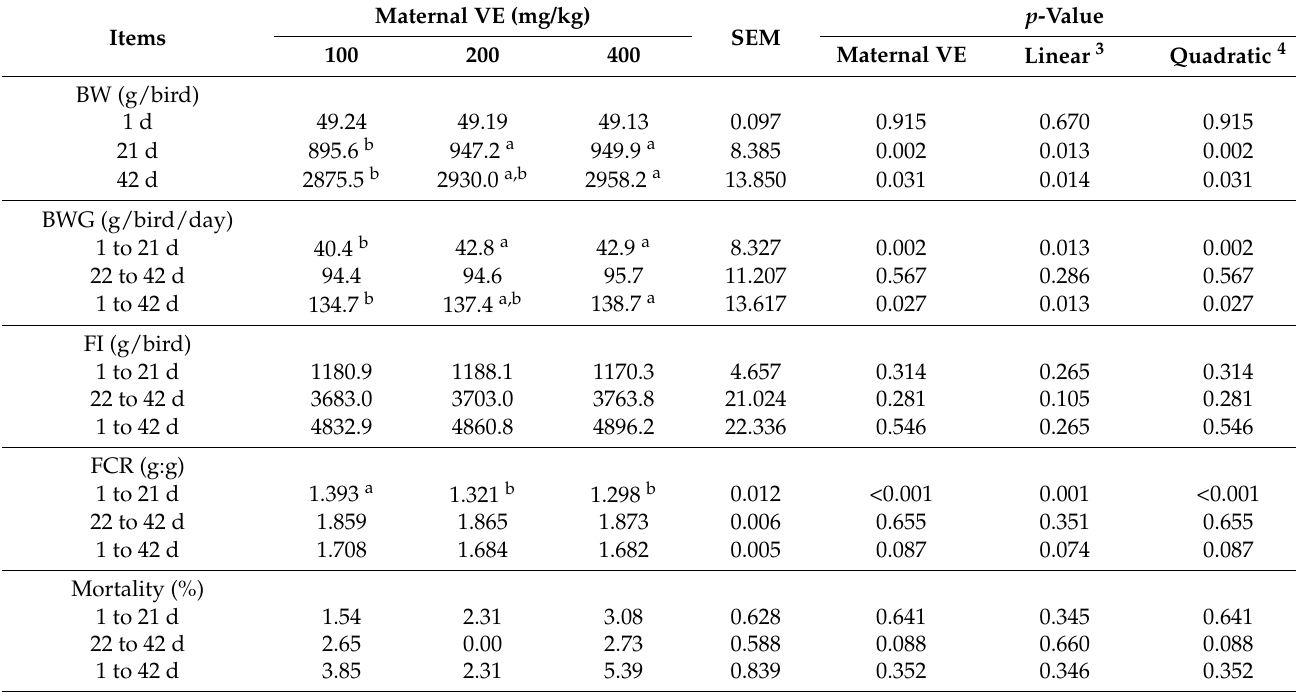
Table 4. Effects of maternal dietary vitamin E supplementation on the growth performance of offspring hatched from stored eggs (trial 2) 1,2